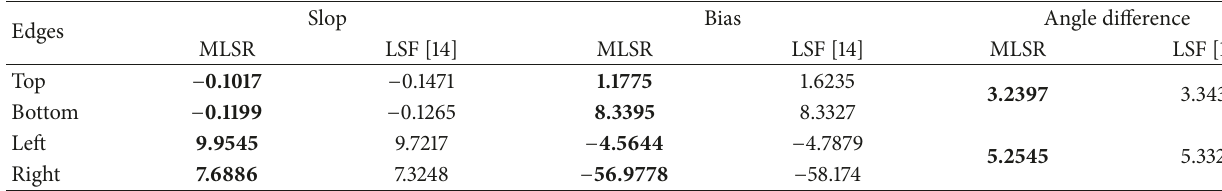
Table 4: Comparisons of position parameters for acquired edges.